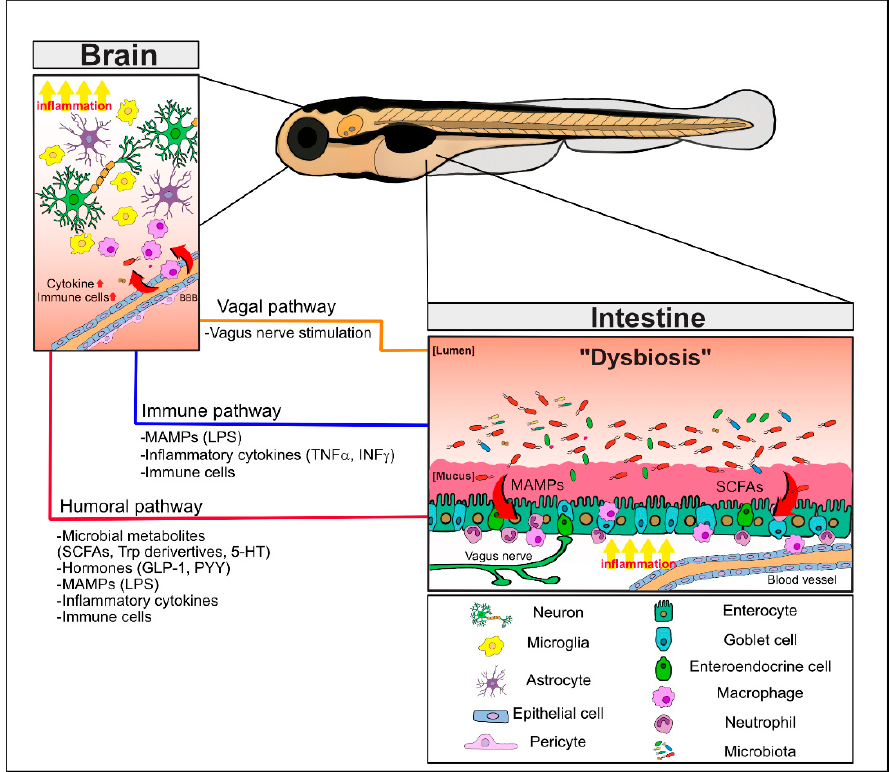
Figure 1. The bidirectional pathways of the microbiota–gut–brain axis (MGBA) involving the mi- crobiota, the intestine, and the brain. Intestinal dysbiosis and derived metabolites in neuropatho- logical conditions induce the barrier permeability defects and local inflammation with increased pro-inflammatory cytokines, MAMPs (e.g., LPS), and activation of immune cells in the gastrointesti- nal tract. These signaling mediators as well as microbial metabolites (e.g., SCFAs and Trp derivatives) and hormones (e.g., GLP-1, PYY) can distantly affect the brain function via the humoral pathway. In addition, dysregulated regulation of the vagus nerve can also directly modulate the brain function. Together, these MGBA pathways culminate in regulating neuroinflammation and neuronal defects of the brain and behavioral abnormalities. Refer to the text for details. 5-HT; 5-hydroxyltryptamine; LPS, lipopolysaccharides; MAMPs, microbe-associated molecular patterns; SCFAs, short chain fatty acids; Trp;